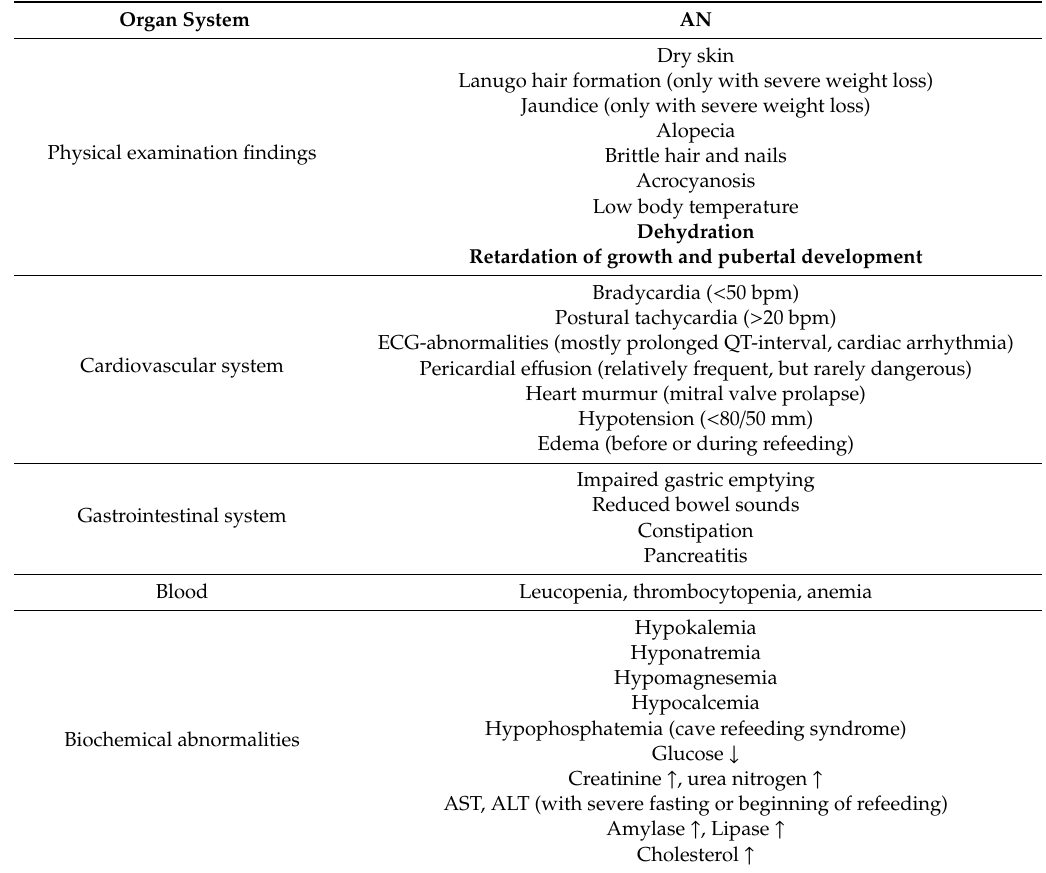
Table 1. Physical changes in childhood anorexia nervosa (AN) (after Reference